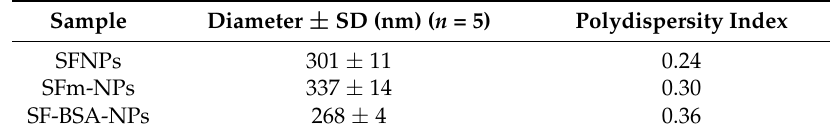
Table 5. Diameter of magnetic and fibroin-albumin nanoparticles measured by Dynamic Light